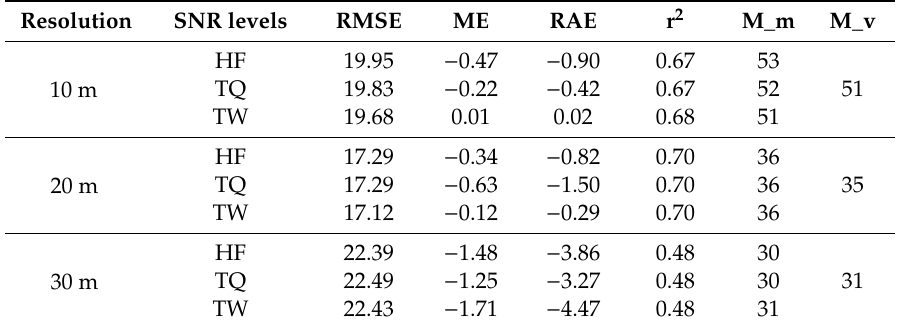
Table 3. Statistical metrics including RMSE, ME, and RAE in percentages in Beltsville. Correlations between validation data and model estimates, median values in percentage of model estimate (M_m), and validation (M_v).